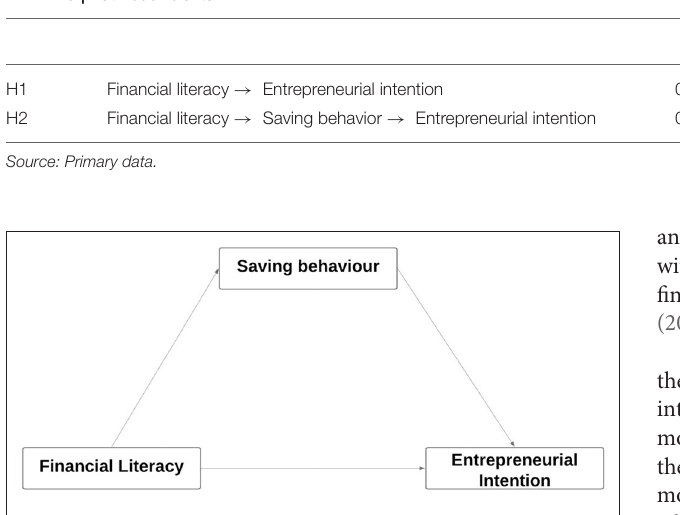
TABLE 8 | Path coefficients.